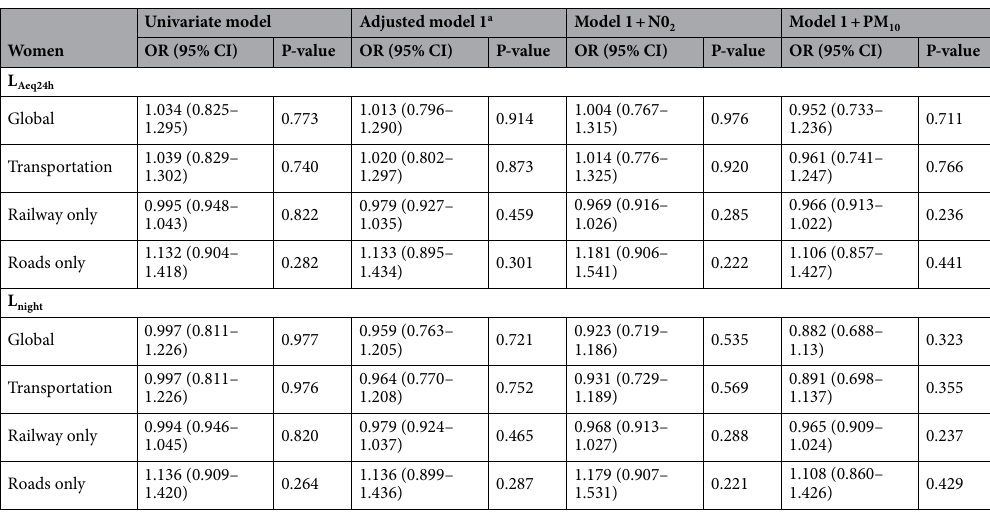
Table 4. Associations between noise exposure and risk categories of TRS-2P score, stratified by sex, women’s table. Odds ratios associated to noise exposure expressed for an increase of 10 dB(A). OR odds ratio, CI confidence interval. a Model 1: Model adjusted on socio-economic level and cardiac